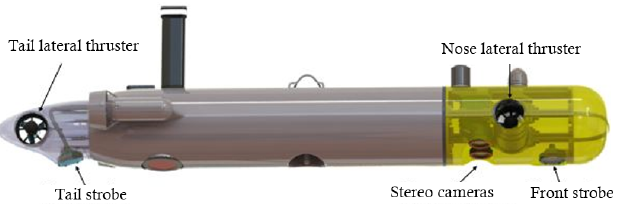
Figure 4. ALICE AUV—An autonomous platform for acquiring high-resolution 3D photomosaics. The wet payload section consists of the nose lateral thruster, the stereo cameras, and the front strobe. The tail section was redesigned to fit a second lateral thruster and the tail strobe. A GPU, LED drivers, and a microcontroller to trigger the strobes were fitted in the vehicle’s dry